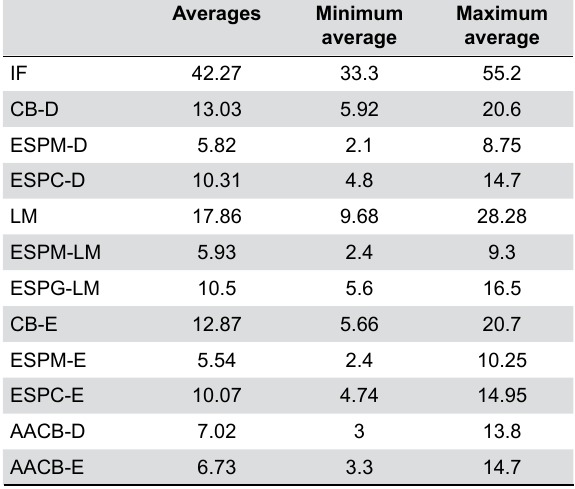
Table 1- Mean, minimum and maximum measures of all distance measurements in the parasagittal reformation, 0.30 mm